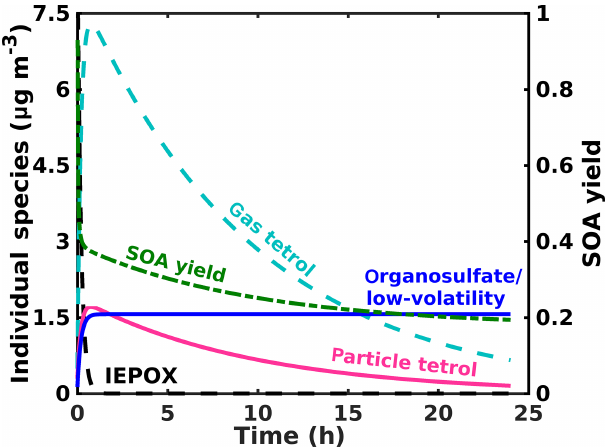
Figure 8. Model results for the major gas- and particle-phase species of IEPOX reactive uptake for typical atmospheric aerosol and typical IEPOX mixing